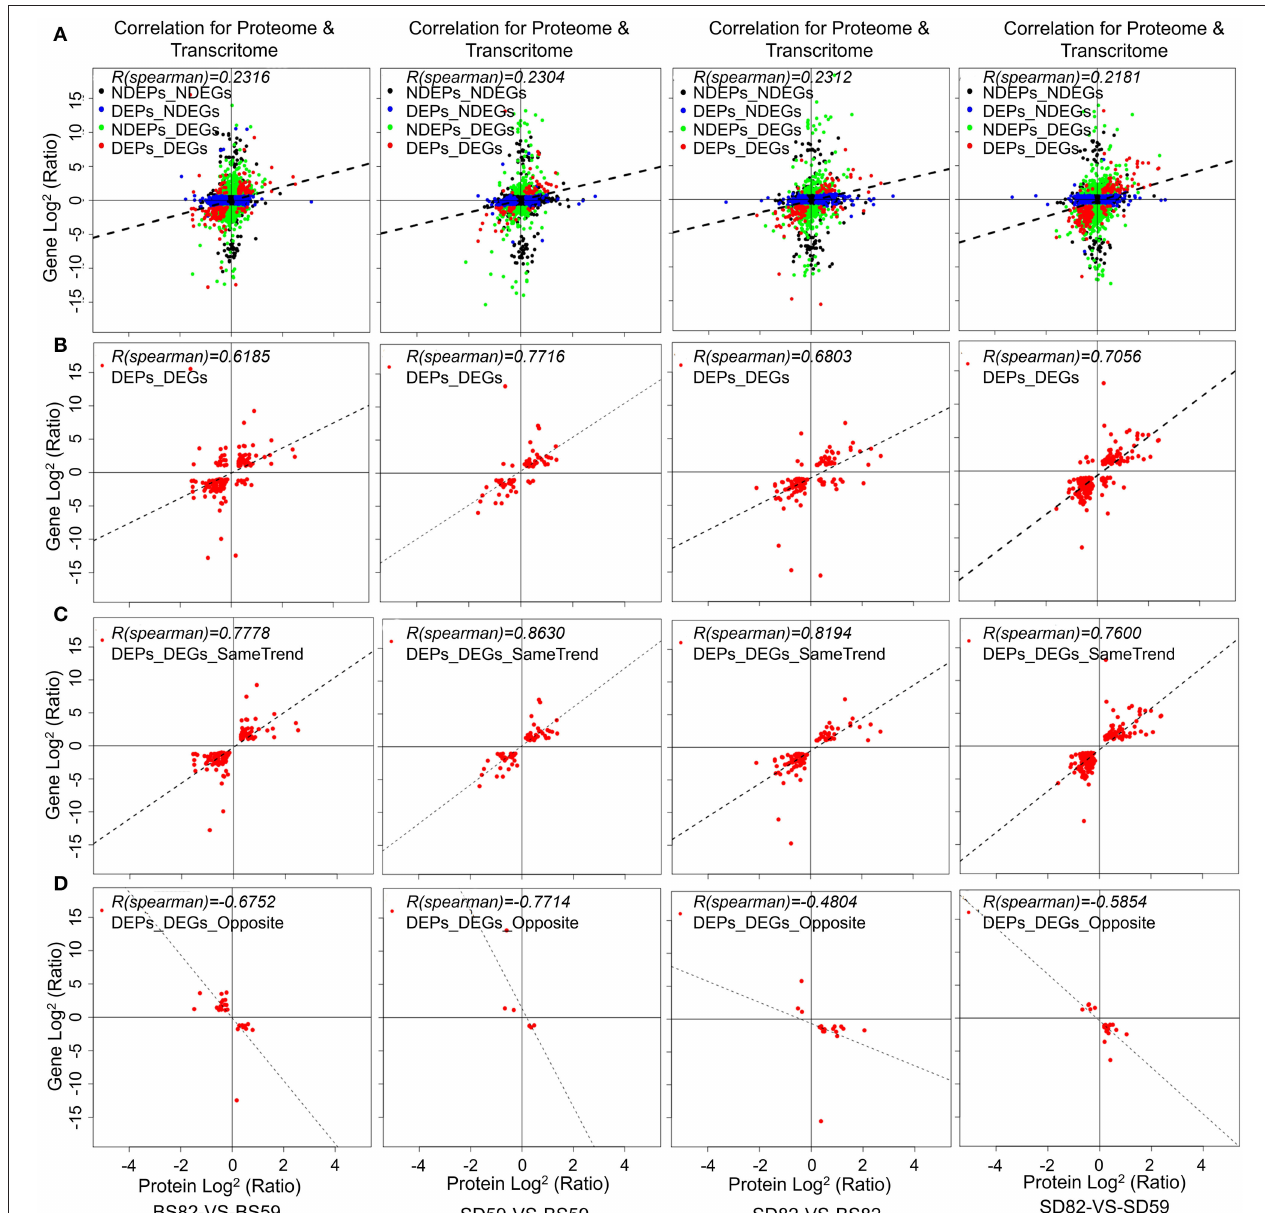
FIGURE 2 | Correlations between protein and mRNA expression. X-axis represents the protein expression level, and Y-axis represents the gene expression level. (A) Scatterplots of the relationship between genes quantified in both transcriptomic and proteomic in BS59-VS-BS82, BS59-VS-SD59, BS82-VS-SD82, and SD59-VS-SD82 groups. (B) Scatterplots and correlation coefficients between DEGs (differentially expressed genes) and DEPs (differentially expressed proteins). Scatterplots and correlation coefficients between proteins and mRNA expression ratios which are the same (C) or opposite (D) changing tendency. The black plot indicates none DEPs and DEGs; blue plot indicates DEPs but none DEGs; green plot indicates DEGs but non DEPs; red plot indicates DEPs and DEGs, and all data were